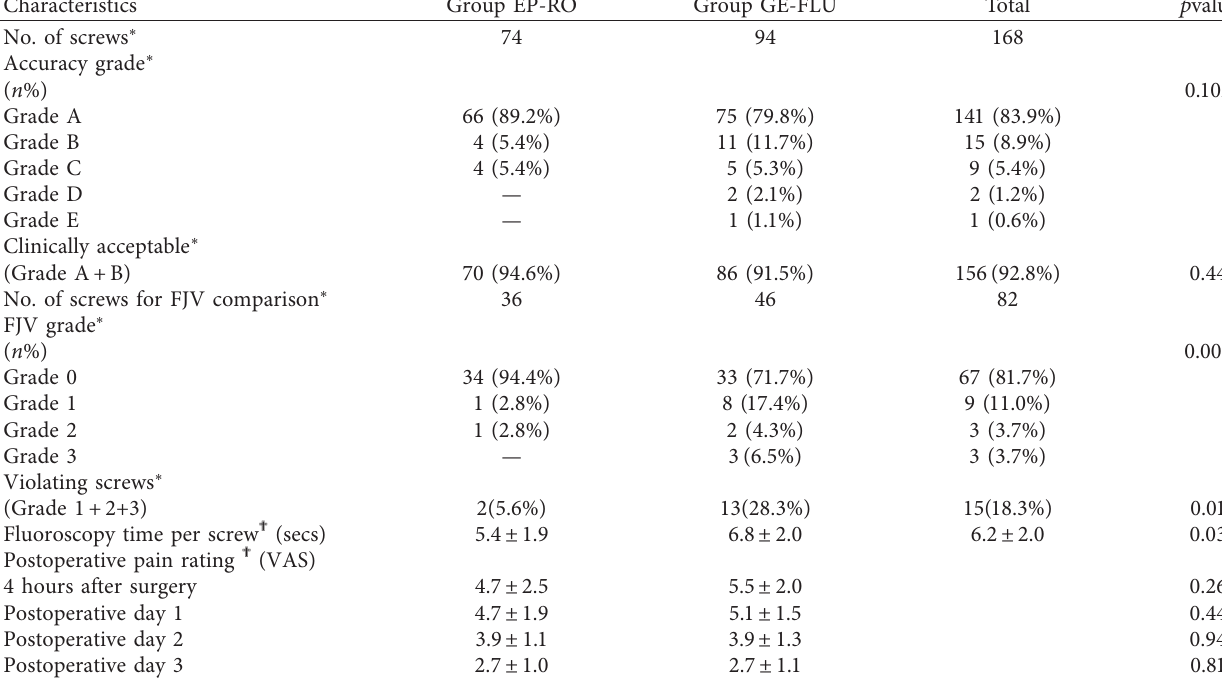
Table 3: Comparison of pedicle screw placement accuracy, FJV, and fluoroscopy